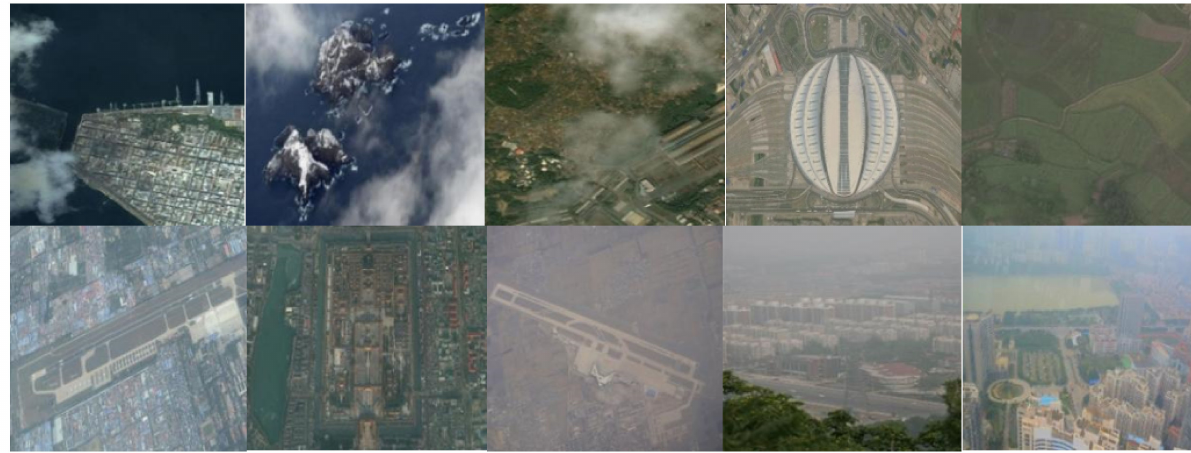
Figure 12. Part of the foggy remote sensing